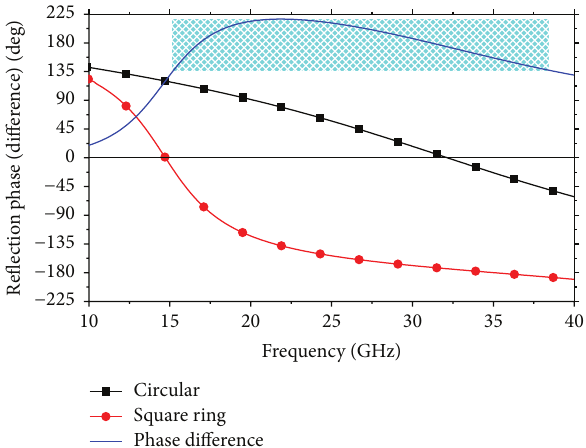
Figure 2: Reflection phases of two EBG structures and phase difference between